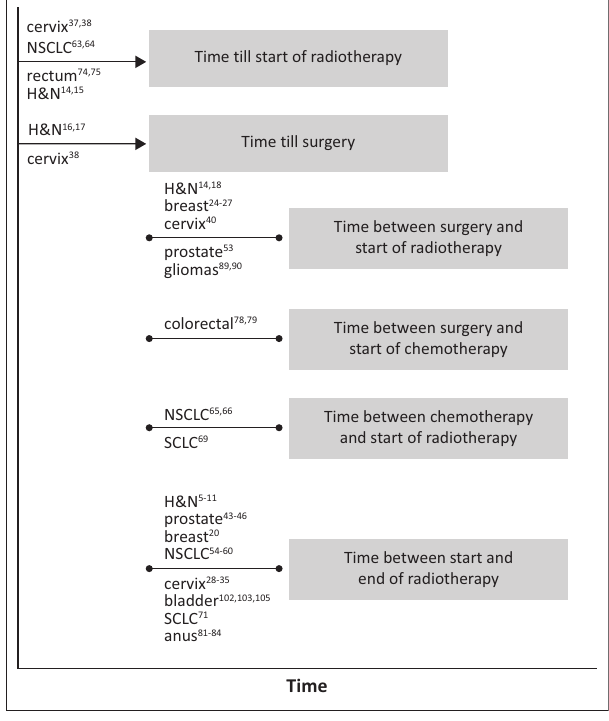
overall radiotherapy treatment